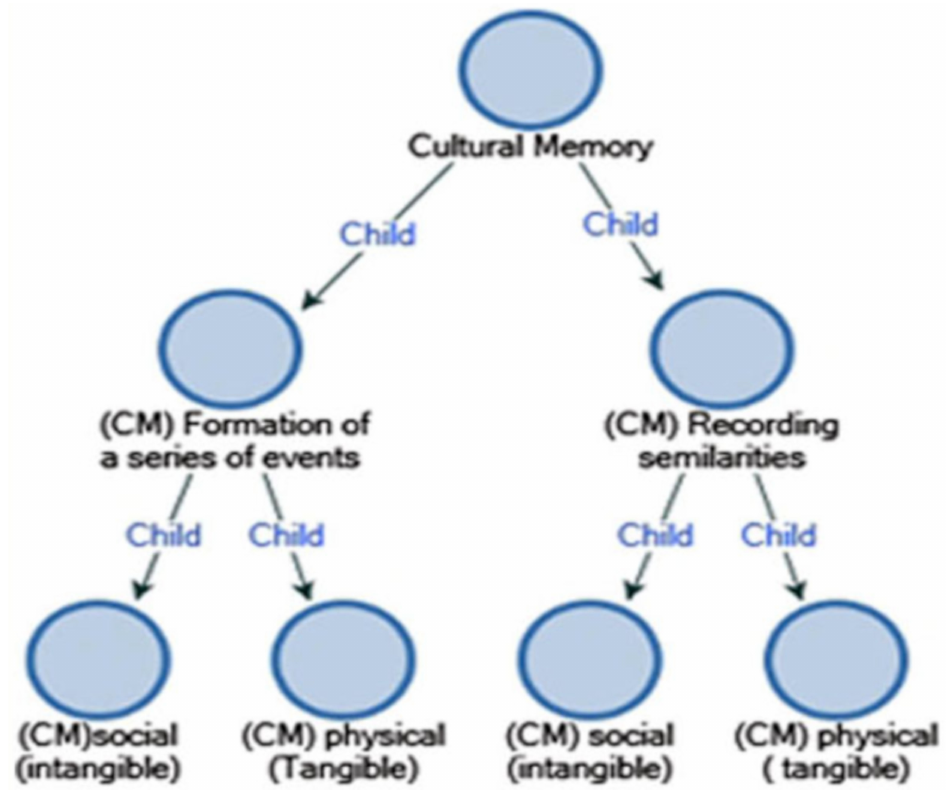
Figure 5. Part of the research tree node structure, showing the cultural memory node and its broken sub-nodes extracted from the Nvivo12 program. Source: F.